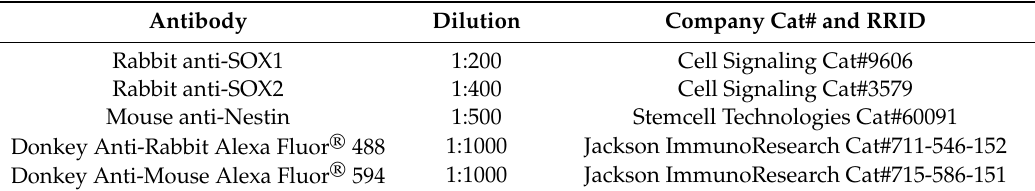
Table 1. Primary and secondary antibodies used in immunofluorescent